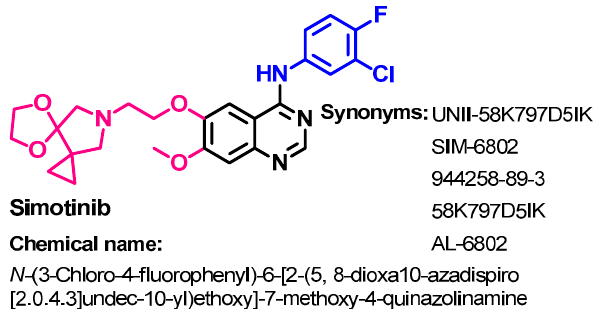
Figure 61. Chemical structure/name/synonyms of simotinib.